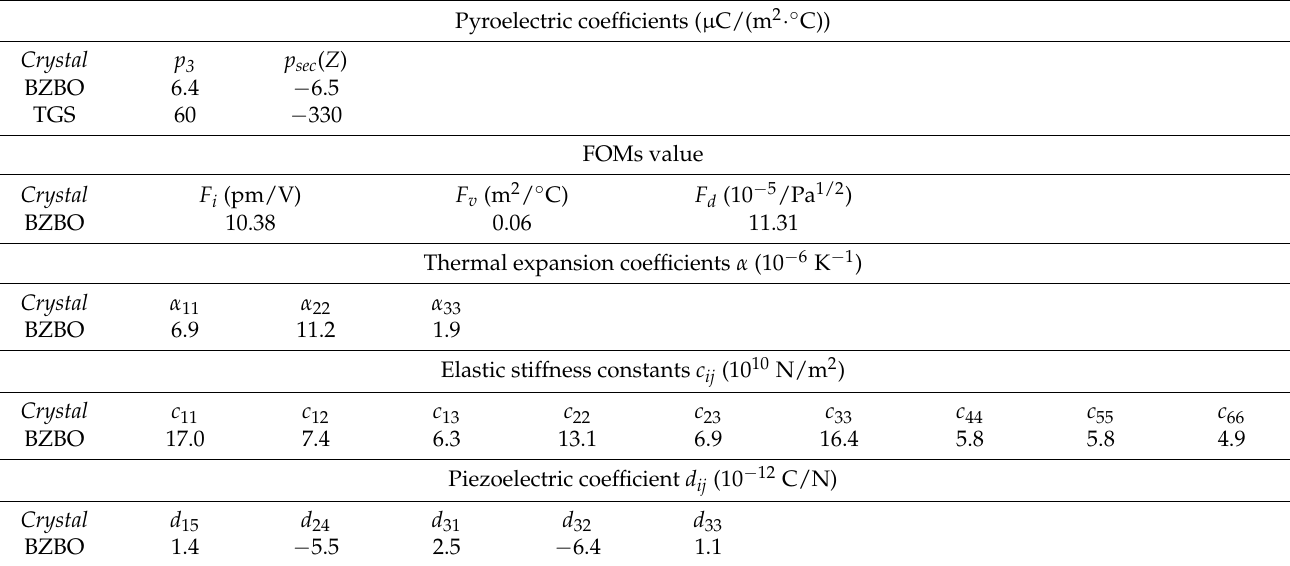
Table 1. Properties of Bi 2 ZnB 2 O 7 (BZBO) pyroelectric crystals at 15 ◦